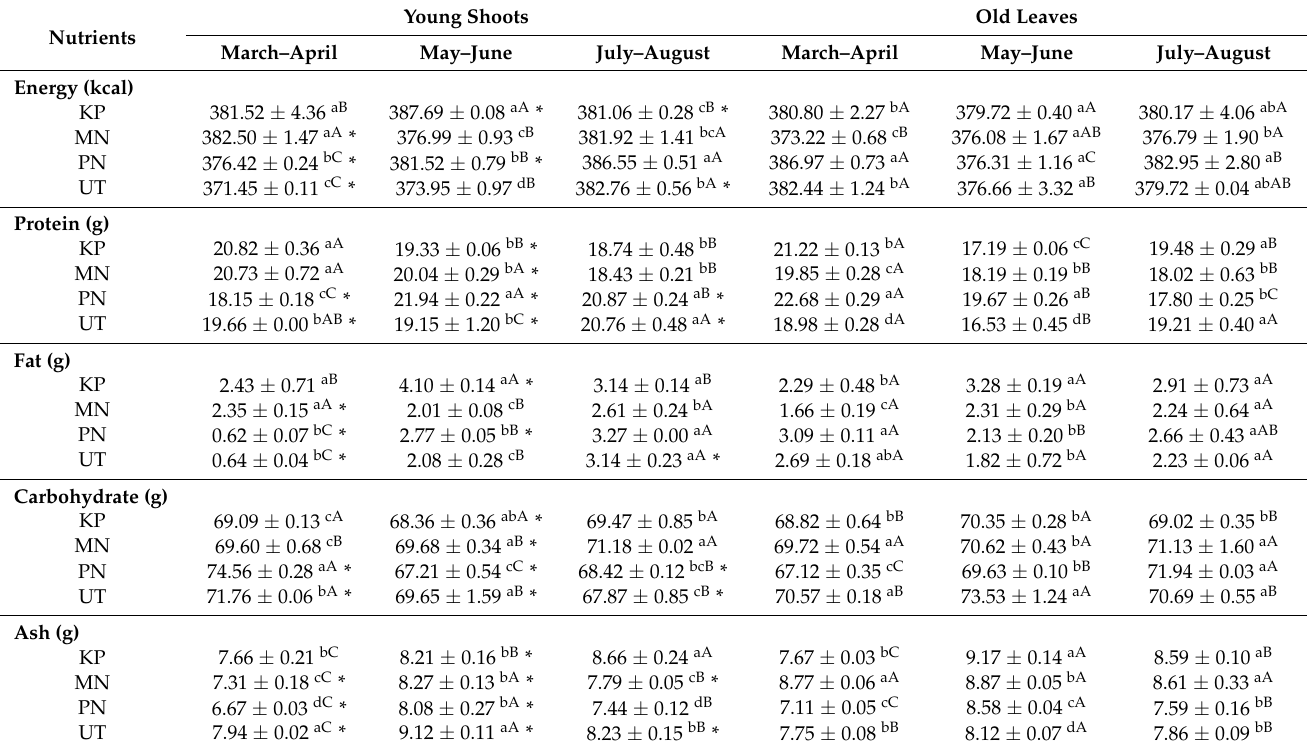
All data were expressed as mean ± standard deviation (SD) of triplicate experiments ( n = 3). Small letters indicate significant different values ( p < 0.05) in the same plant parts of different originated A. viridiflora Craib. collected from the same harvesting periods, while capital letters indicate significant different values ( p < 0.05) in the same plant parts of the same originated A. viridiflora Craib. collected from different harvesting periods using one-way analysis of variance (ANOVA) and Duncan’s multiple comparison test; * indicates significant different values ( p < 0.05) between young shoot and old leaves of the same originated A. viridiflora Craib. collected from the same harvesting period using unpaired t